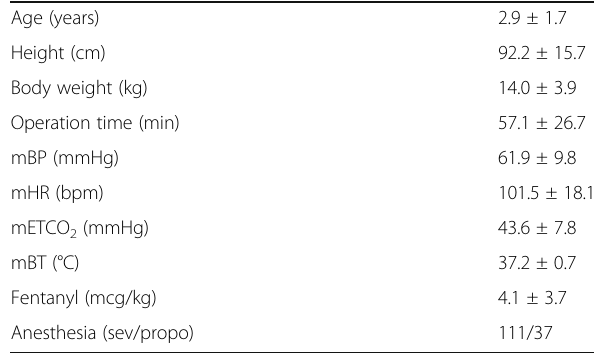
Table 1 Patients ’ demographic and operative